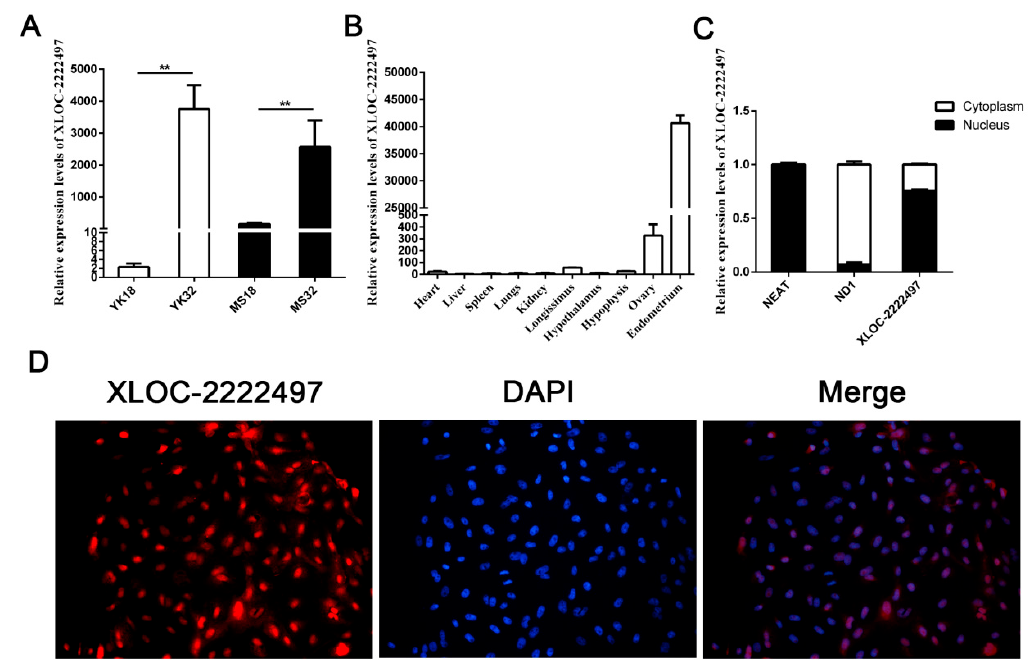
Figure 4. Feature identification of XLOC-2222497 . ( A ) RNA expression profile of XLOC-2222497 in the endometrium from Meishan and Yorkshire pigs on days 18 and 32 of pregnancy by qRT-PCR. ** represents p < 0.01. ( B ) Expression profile of XLOC-2222497 in different tissues. ( C ) qRT-PCR results of XLOC-2222497 cell-fractionation assay. ( D ) RNA fluorescence in situ hybridization (FISH) results of XLOC-2222497 for subcellular localization. Red fluorescent probe: XLOC-2222497 ; blue fluorescent probe: 4', 6-diamidino-2-phenylindole (DAPI). Table 1. The predicted coding potential of XLOC-2222497. Gene Coding / Non-Coding Coding Score